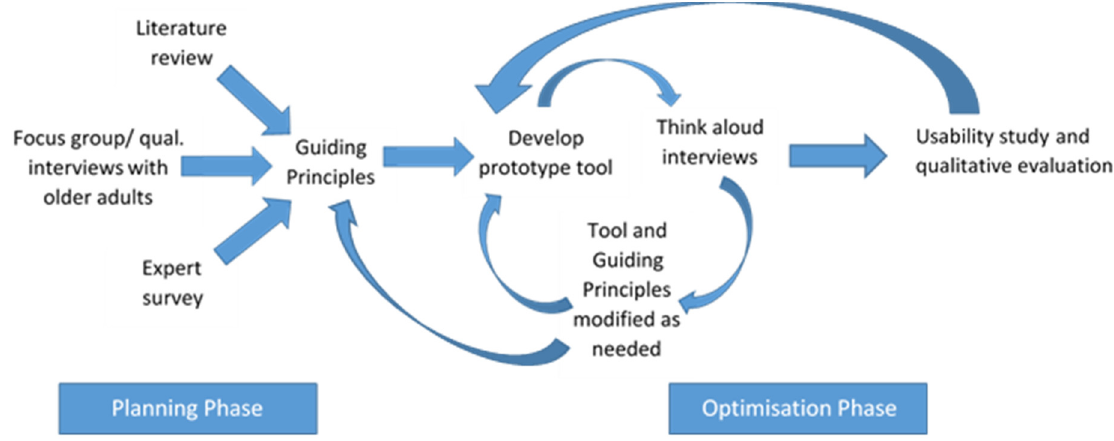
Figure 1. Overview of DAPPA tool development process.